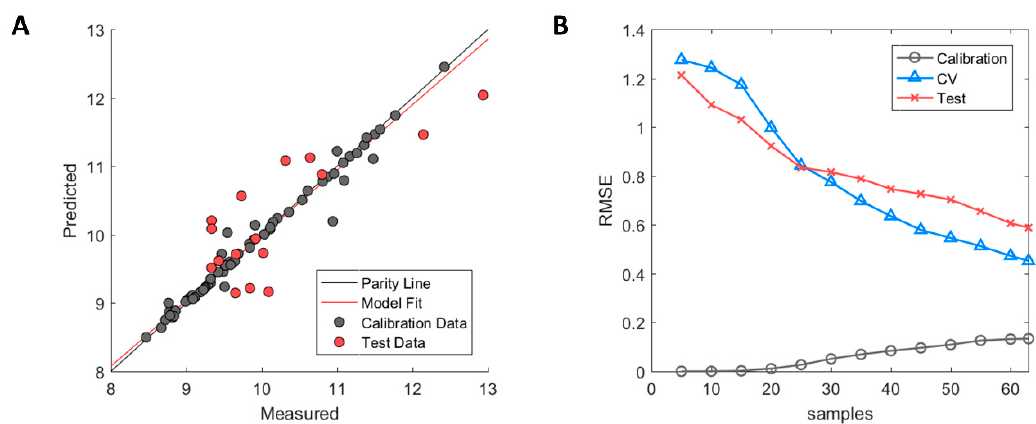
Figure 7. Performance of MD3D based model after GA-PLS selection. ( A ) Measured versus predicted values of calibration (grey) and test set (red) samples. ( B ) Model learning curve for MD-3D based model showing the change of RMSE for calibration (grey circle), cross-validation (blue triangle), and test set (red cross). Optimized ϵ -SVM model parameters from original calibration model were used.